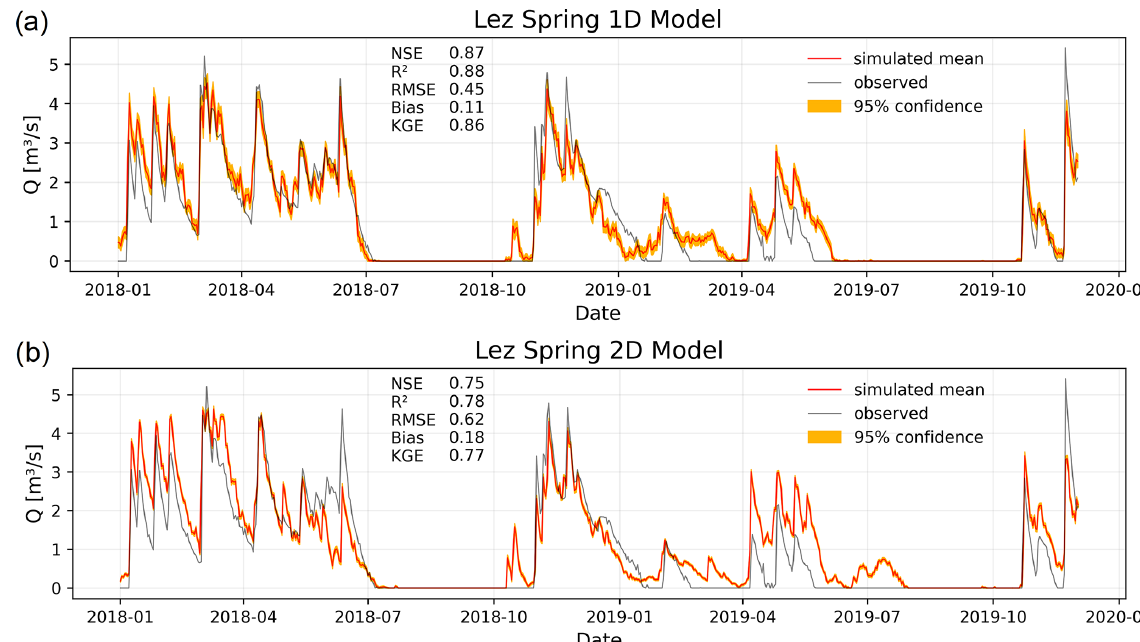
Figure 5. Simulation results for 2018–2019 at Lez spring in France using climate station input data (a) and E-OBS gridded data (b)